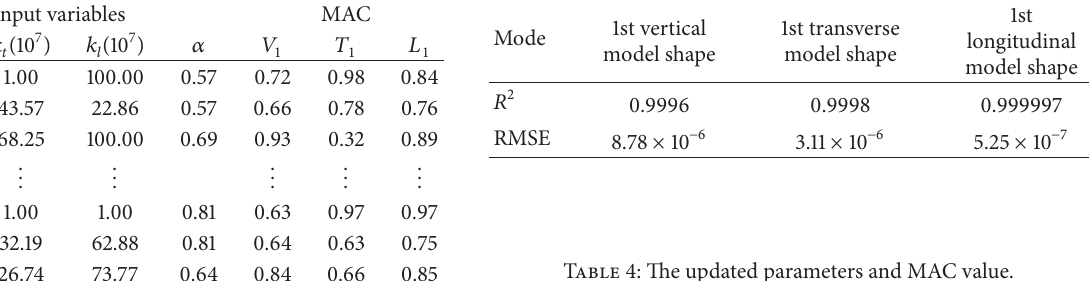
Table 4: The updated parameters and MAC